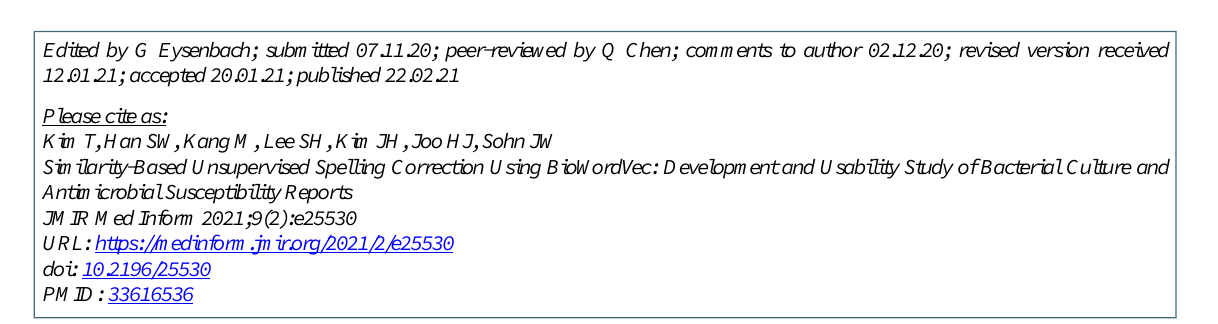
SNOMED: Systematized Nomenclature of